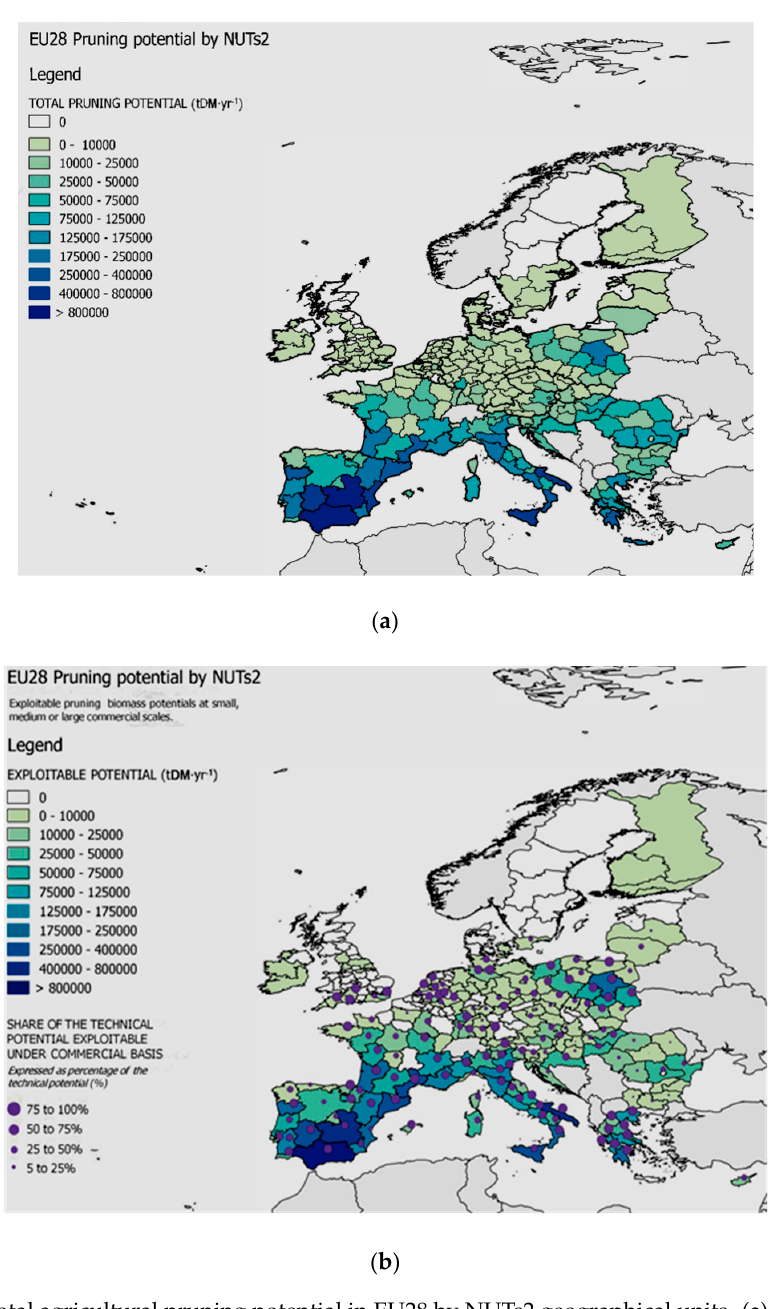
Figure 2. Total agricultural pruning potential in EU28 by NUTs2 geographical units. ( a ) Theoretical potentials. ( b ) Economic potentials exploitable under market demand. potentials. ( b ) Economic potentials exploitable under market